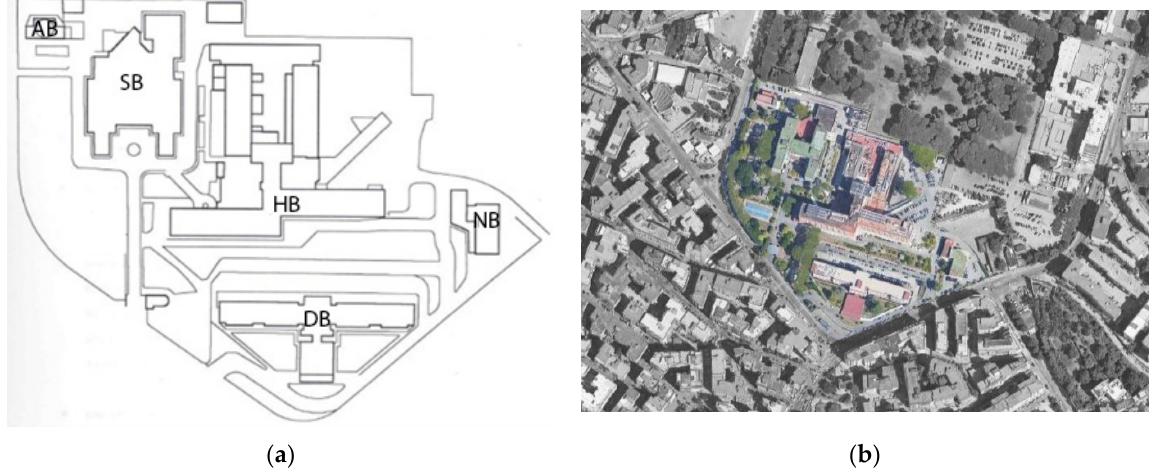
Figure 1. General plan of the institute “G. Pascale Foundation” ( a ) with its satellite view ( b ).